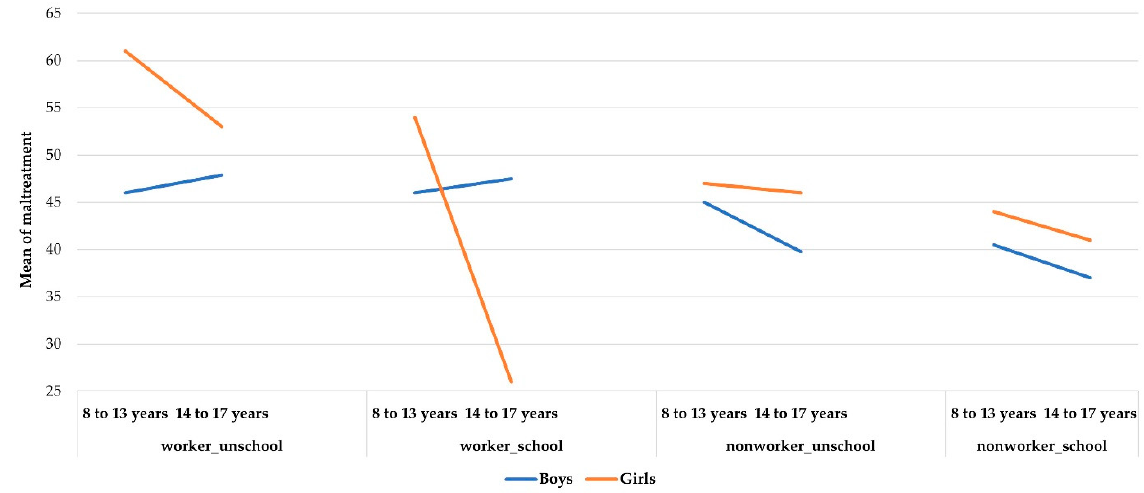
Figure 3. Gender differences for Mistreatment.